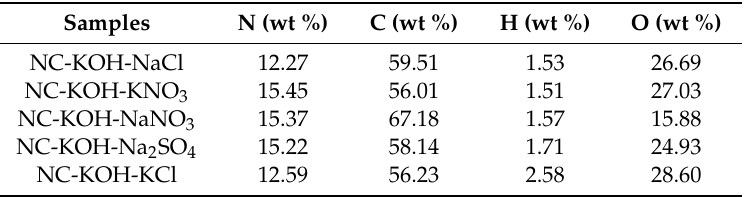
Table 5. The content of N, C, H and O in samples activated by different salts.